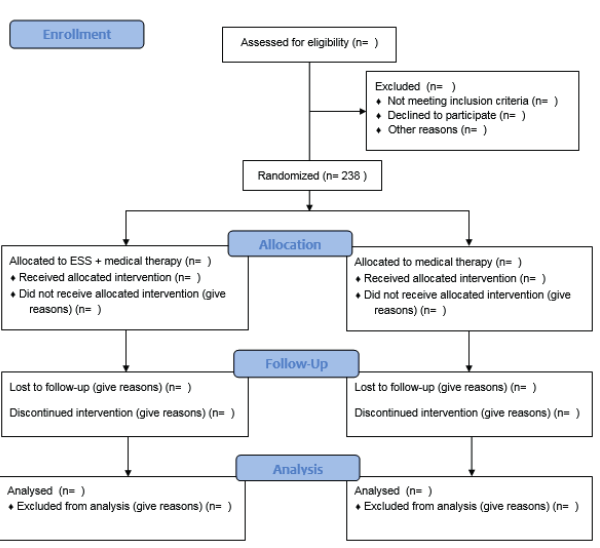
Figure 1. PolypESS CONSORT 2010 flow